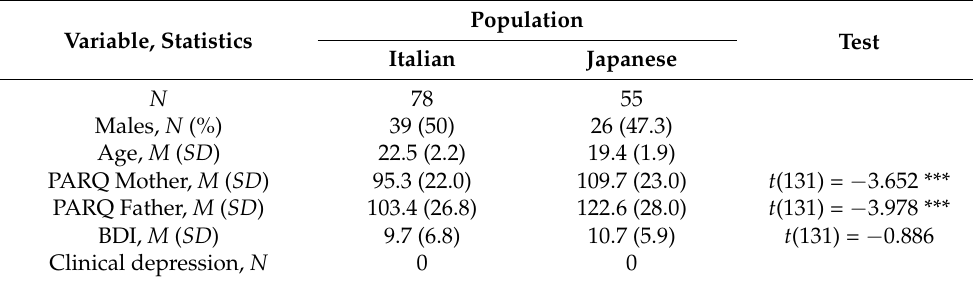
Table 1. Demographic and descriptive data across populations ( N =